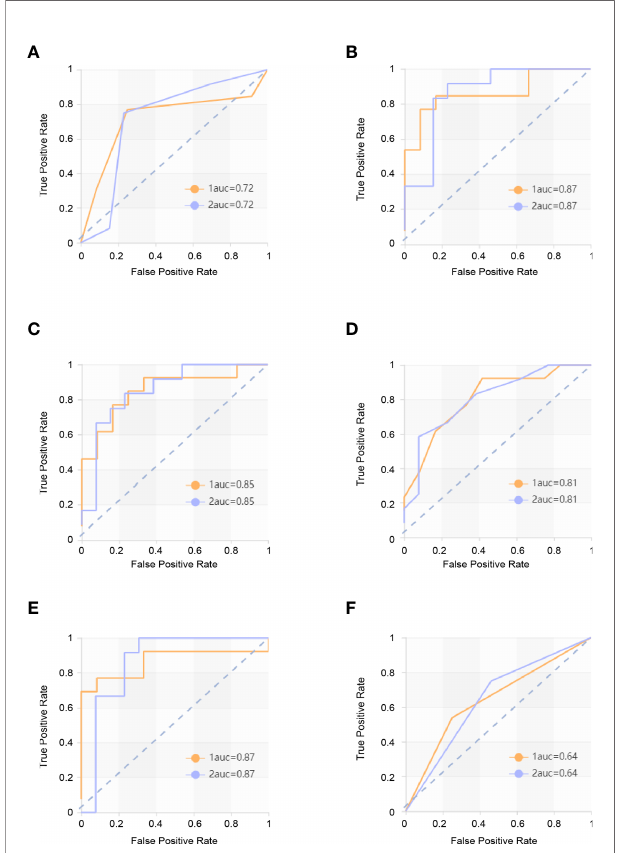
FIGURE 4 | ROC curves in portal venous phase. The yellow curve is the poor prognosis group (PP group), and the blue curve is the good prognosis group (GP group). (A) ROC curve of the KNN model in the validation set. The AUC were 0.718 in the PP group (sensitivity and speci fi city were 0.77 and 0.75, respectively) and 0.718 in the GP group (sensitivity and speci fi city were 0.75 and 0.77, respectively. (B) ROC curve of the SVM model in the validation set. The AUC were 0.865 in the PP group (sensitivity and speci fi city were 0.77 and 0.83) and 0.865 in the GP group (sensitivity and speci fi city were 0.83 and 0.77, respectively). (C) ROC curve of the XGBoost model in the validation set. The AUC were 0.853 in the PP group (sensitivity and speci fi city were 0.85 and 0.67, respectively) and 0.853 in the GP group (sensitivity and speci fi city were 0.67 and 0.85, respectively). (D) ROC curve of the RF model in the validation set. The AUC were 0.808 in the PP group (sensitivity and speci fi city were 0.62 and 0.83, respectively) and 0.808 in the GP group (sensitivity and speci fi city were 0.83 and 0.62, respectively). (E) ROC curve of the LR model in the validation set. The AUC were 0.865 in the PP group (sensitivity and speci fi city were 0.77 and 0.75, respectively) and 0.865 in the GP group (sensitivity and speci fi city were 0.75 and 0.77, respectively). (F) ROC curve of the DT model in the validation set. The AUC were 0.644 in the PP group (sensitivity and speci fi city were 0.54 and 0.75, respectively) and 0.644 in GP group (sensitivity and speci fi city were 0.75 and 0.54,